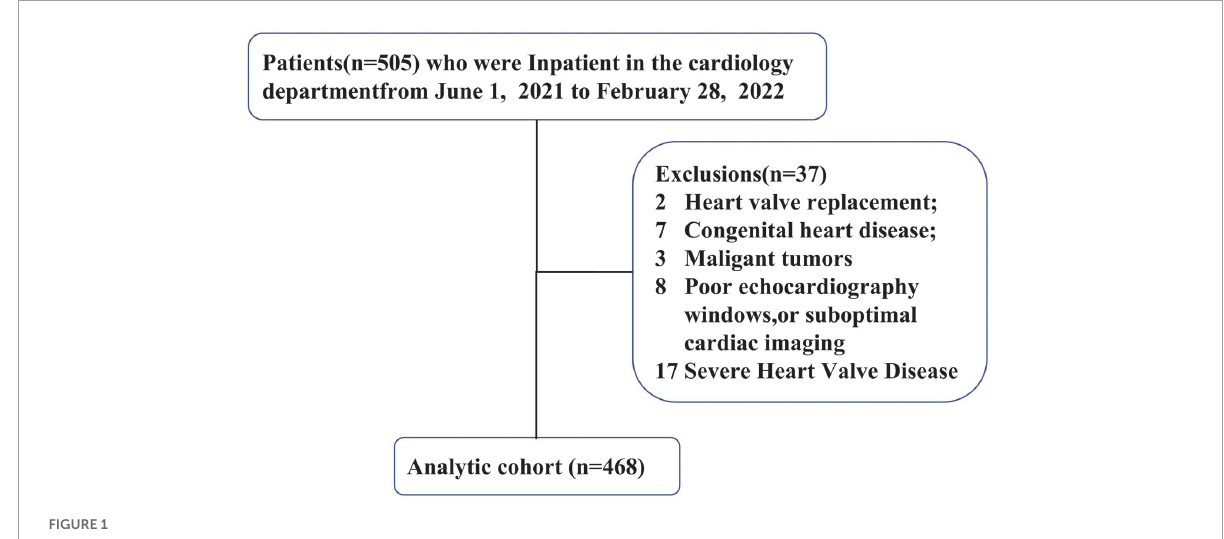
FIGURE1 Flowchart demonstrating the process of selection from a total of 504 patients.